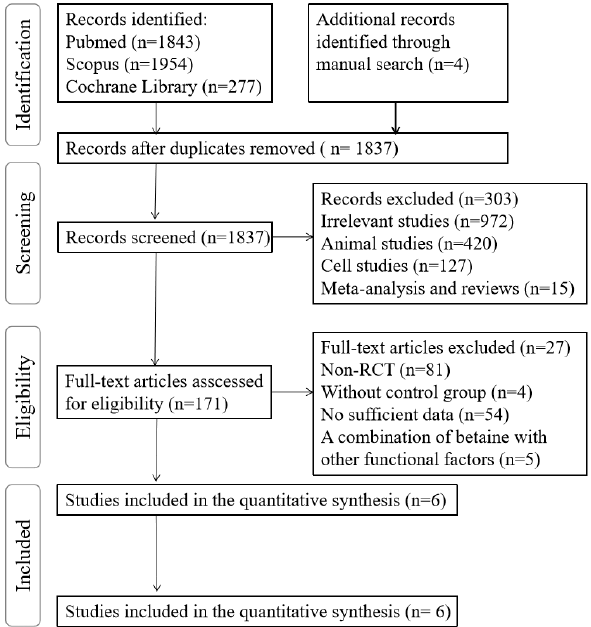
Figure 1. Flowchart of the literature search.